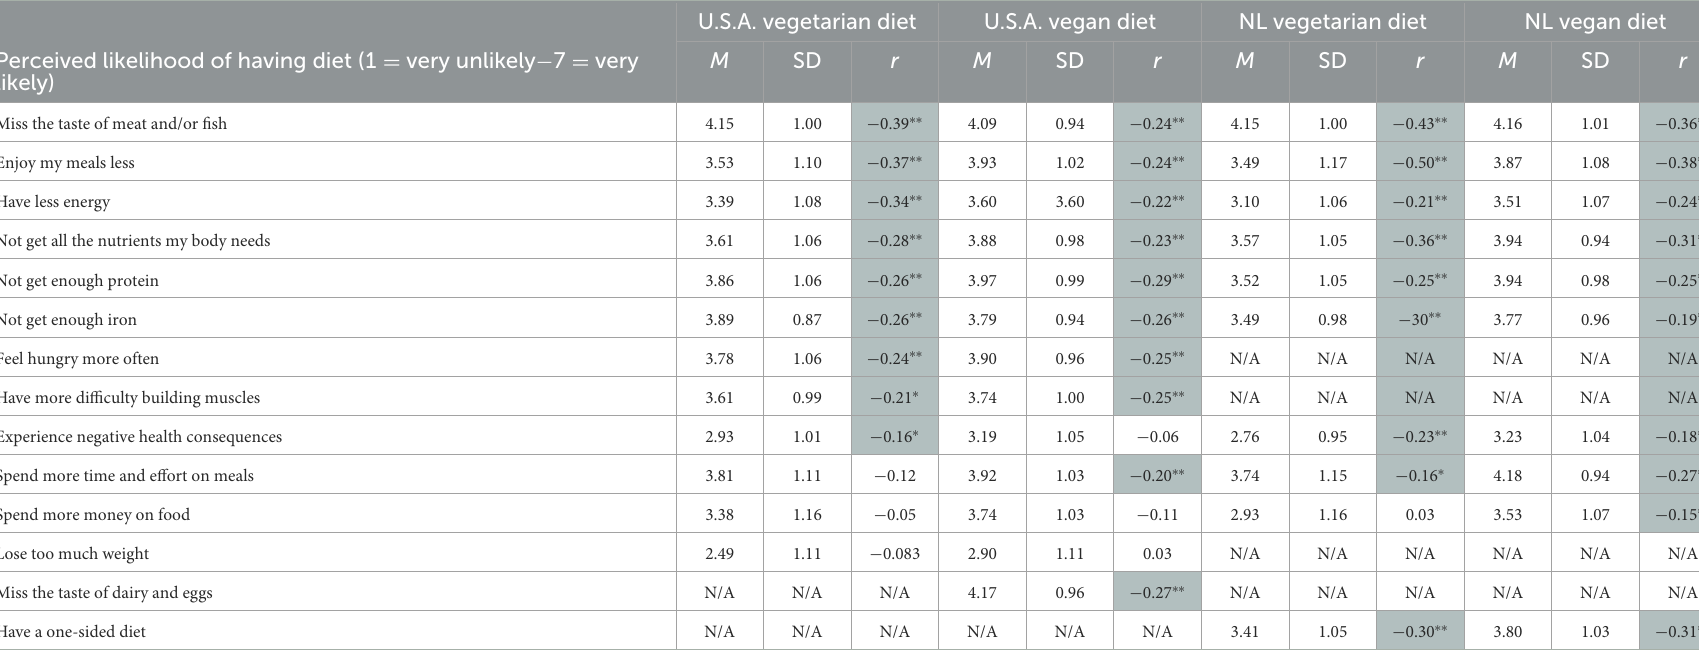
TABLE 7B Negative attitudinal beliefs about having a vegetarian and having a vegan diet: means (M), standard deviations (SD), and correlation (r) with behavioral intention.